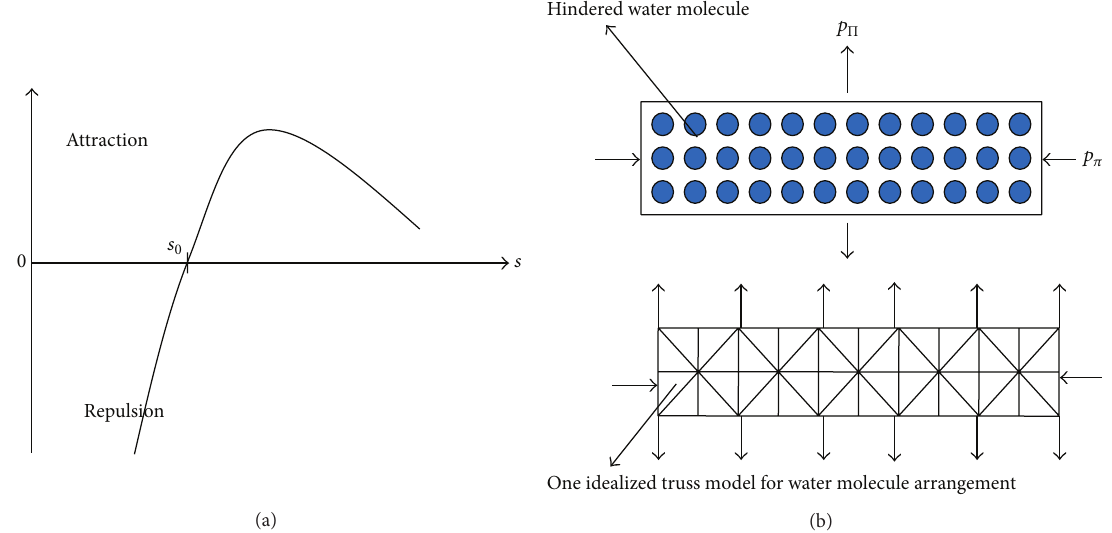
Figure7:(a)Interatomicforceineachindividualwatermolecule;(b)anidealizedwatermoleculearragementmodelforcorrelatingdisjoining pressure and spreading